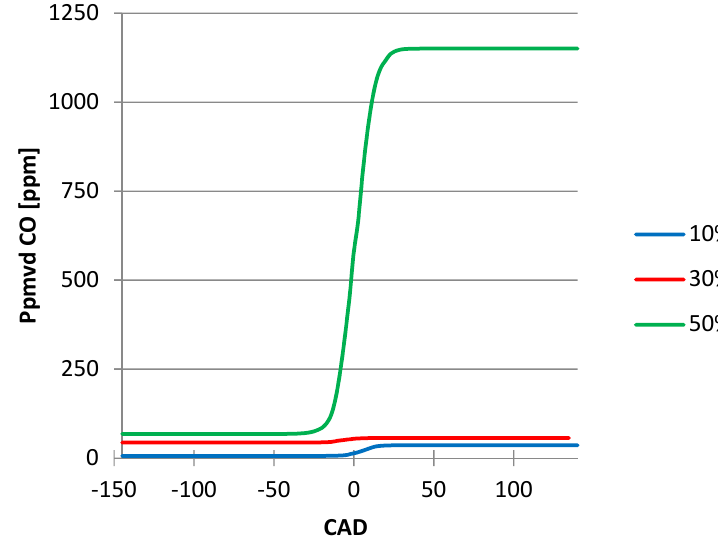
Figure 7. EGR ratio influence on CO emissions.